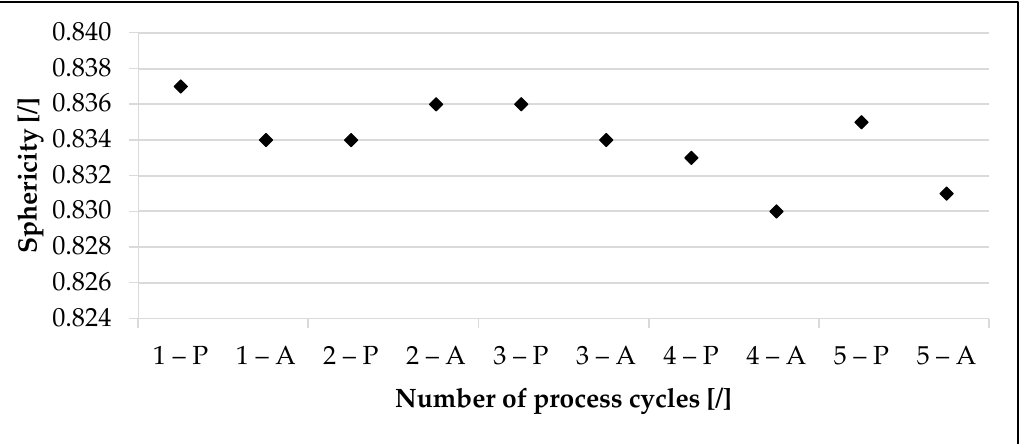
Figure 3. Influence of cyclic reuse on the sphericity of the used polyamide 12 sinter material. Five process cycles were considered. The printing powder (P) and the aged powder (A) were analyzed respectively. The refresh rate was 30 wt%. Determined with Camsizer XT.